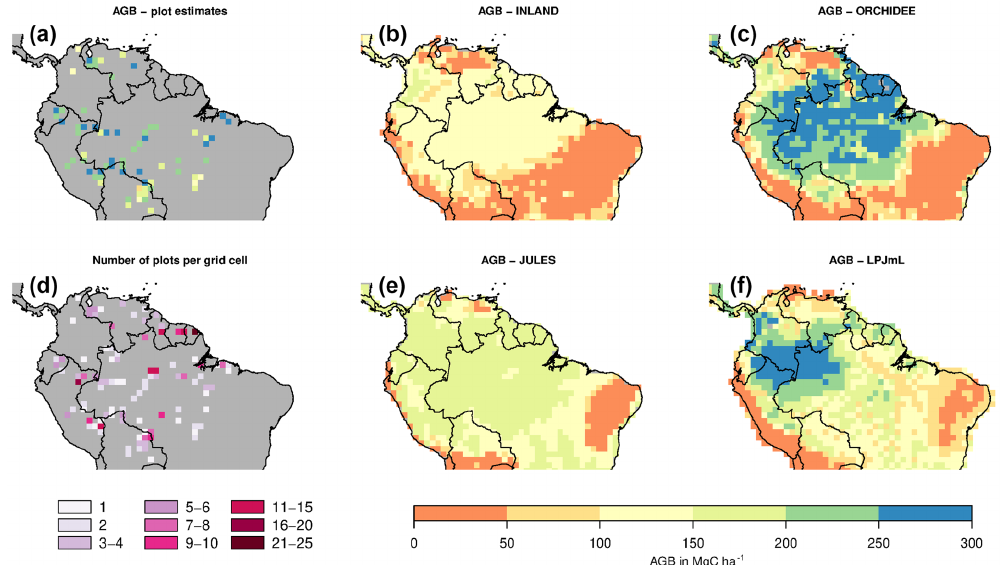
Figure 2. Estimates of aboveground biomass (AGB) from forest plots in 1 ◦ × 1 ◦ pixels. (a) Mean AGB per pixel derived from inventory data based on one allometric equation ( K DH ρ , see the Supplement for explanation and other allometric equations). (b) Number of plots per pixel and (c–f) simulated AGB from four DGVMs.